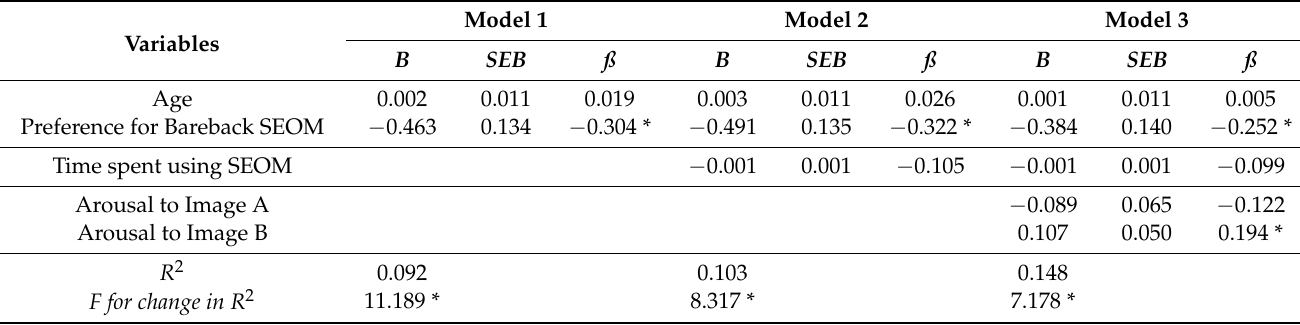
Table 6. Hierarchical Multiple Regression Analysis Predicting Receptive Anal Sex Without